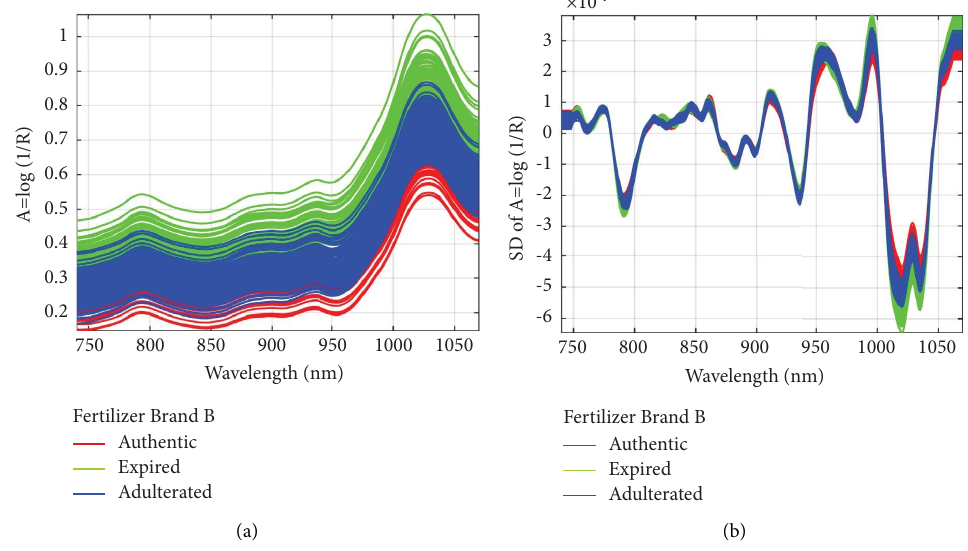
Figure 2: Spectra profle: (a) raw and (b) SGSD of fertilizer B categories.